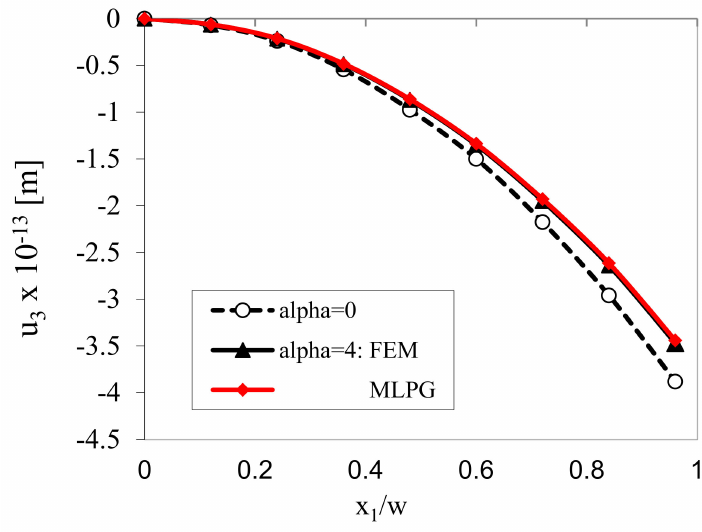
Figure 3. Variation of the mechanical displacement u 3 at x 3 = w /